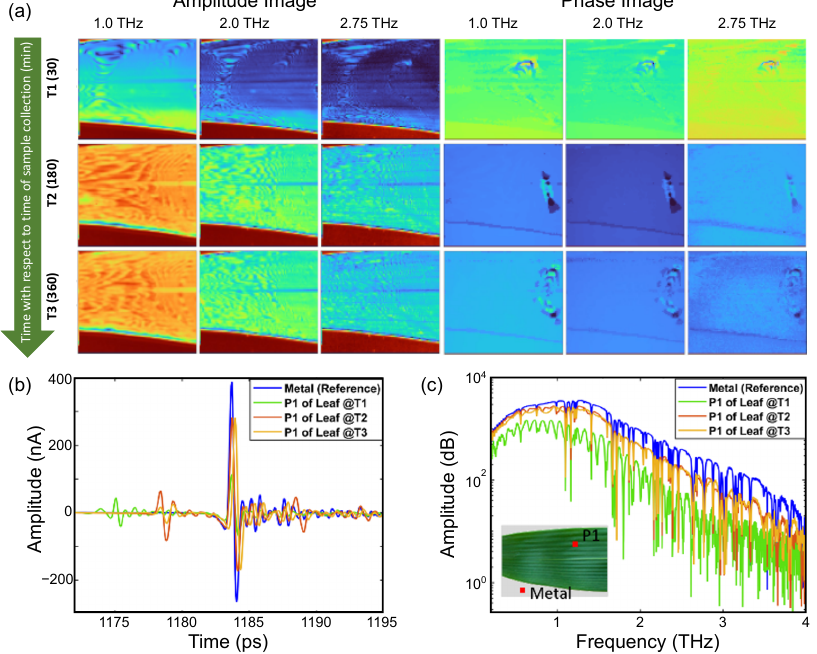
Figure 6. ( a ) Amplitude and phase images of a Bambusa vulgaris leaf acquired after 30 min (T1), 180 min (T2), and 360 min (T3) from plucking, extracted at different frequency points. The color contrast in amplitude image represents variation in reflectivity while the color contrast in phase image represents the variation in phase accumulation. For a continuous progression from 1 to 3 THz, see Video S1, and ( b ) THz time-domain response and ( c ) amplitude spectrum of leaf (from position P1) and metal acquired at time T1, T2, and T3, showing degree of dryness in the leaf. The visual image of the leaf is shown in the inset of the amplitude spectrum and the data were extracted from pixels shown in red in the